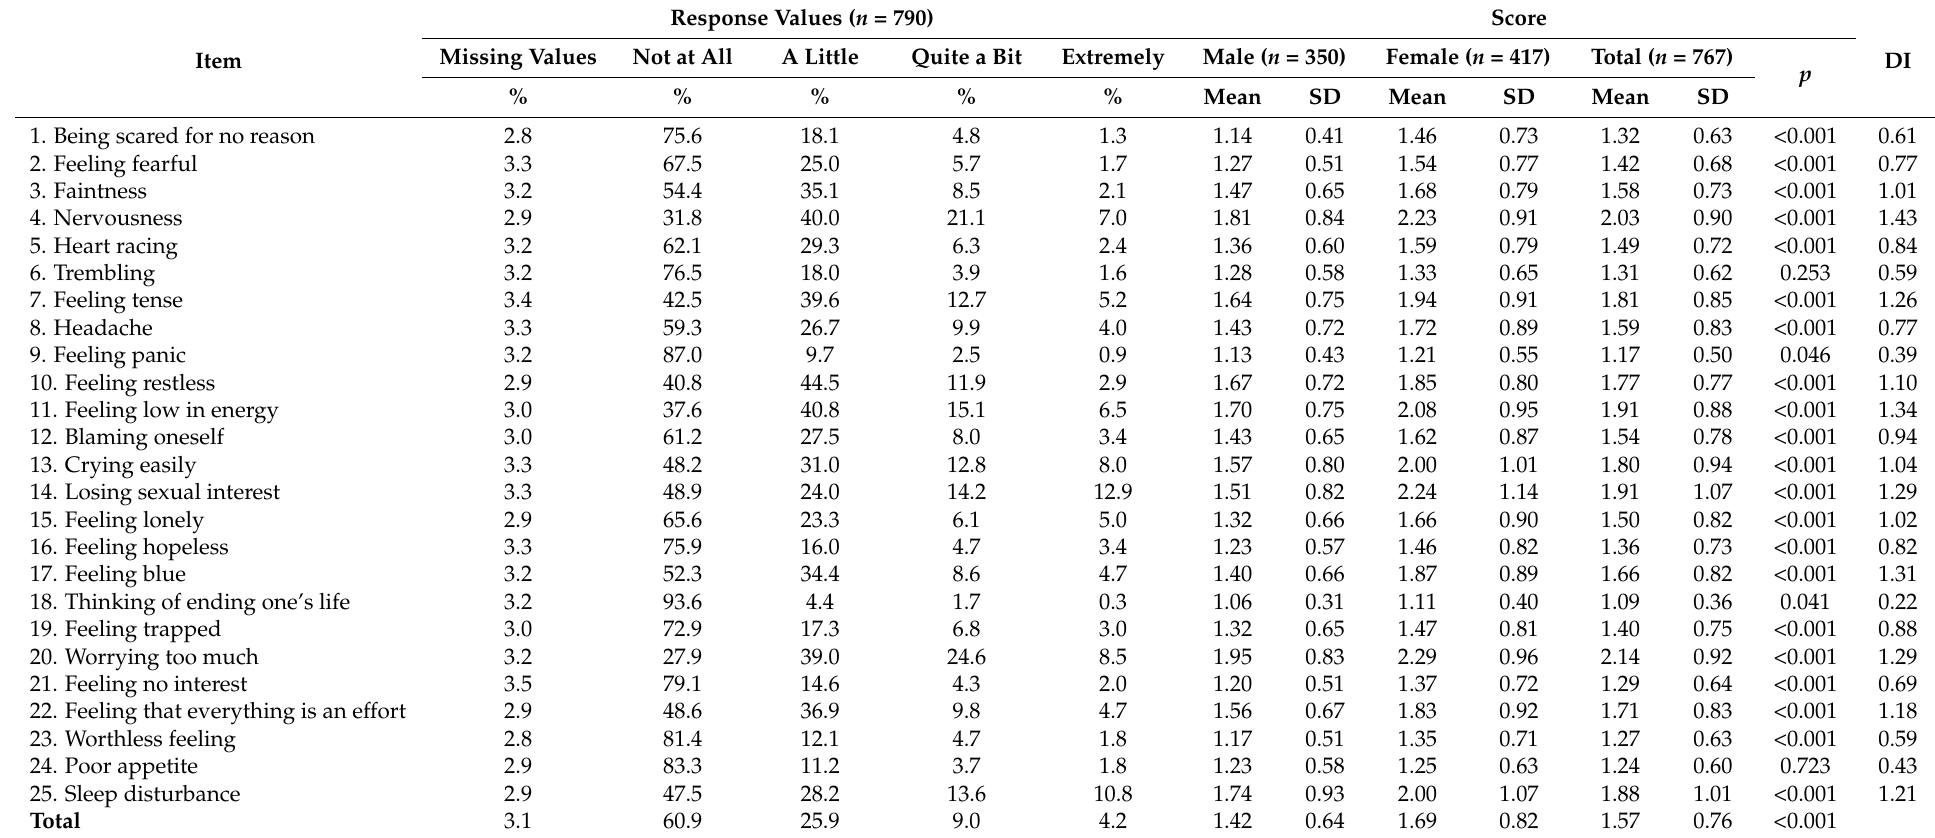
Table 2. Item analysis: missing values, response distribution, mean score, and discrimination